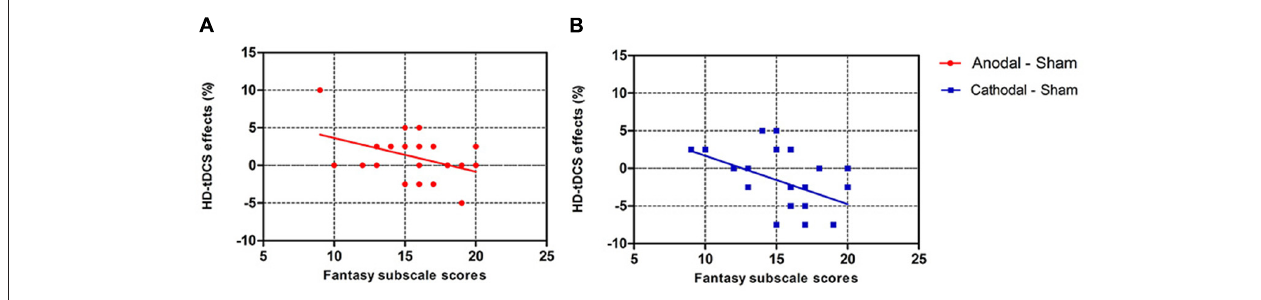
FIGURE 6 | Scatter diagram showing correlations between scores of the Fantasy subscale and HD-tDCS effects for accuracy in cognitive empathy ( A , anodal r = − 0.420, p = 0.046; B , cathodal r = − 0.468, p = 0.024). Note that equal HD-tDCS effects of participants sometimes might be covered by only one data